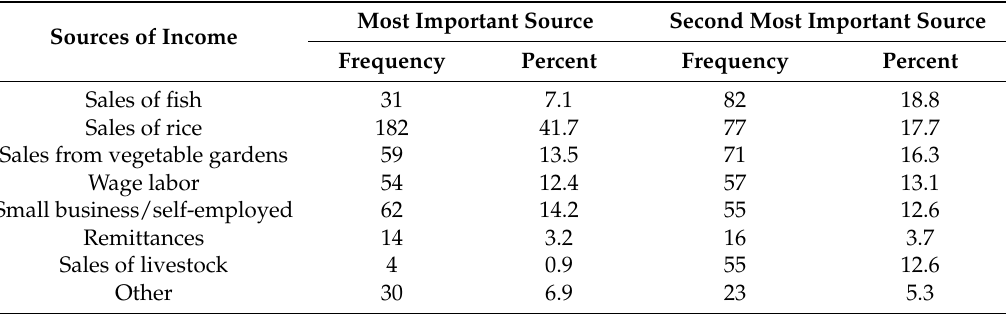
Table 2. Sources of household income.